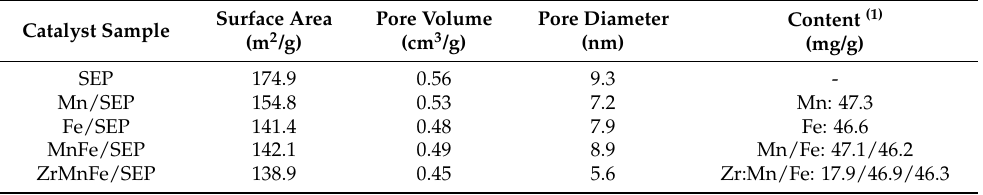
Table 1. Physical properties of the metal-doped sepiolite catalysts. Catalyst